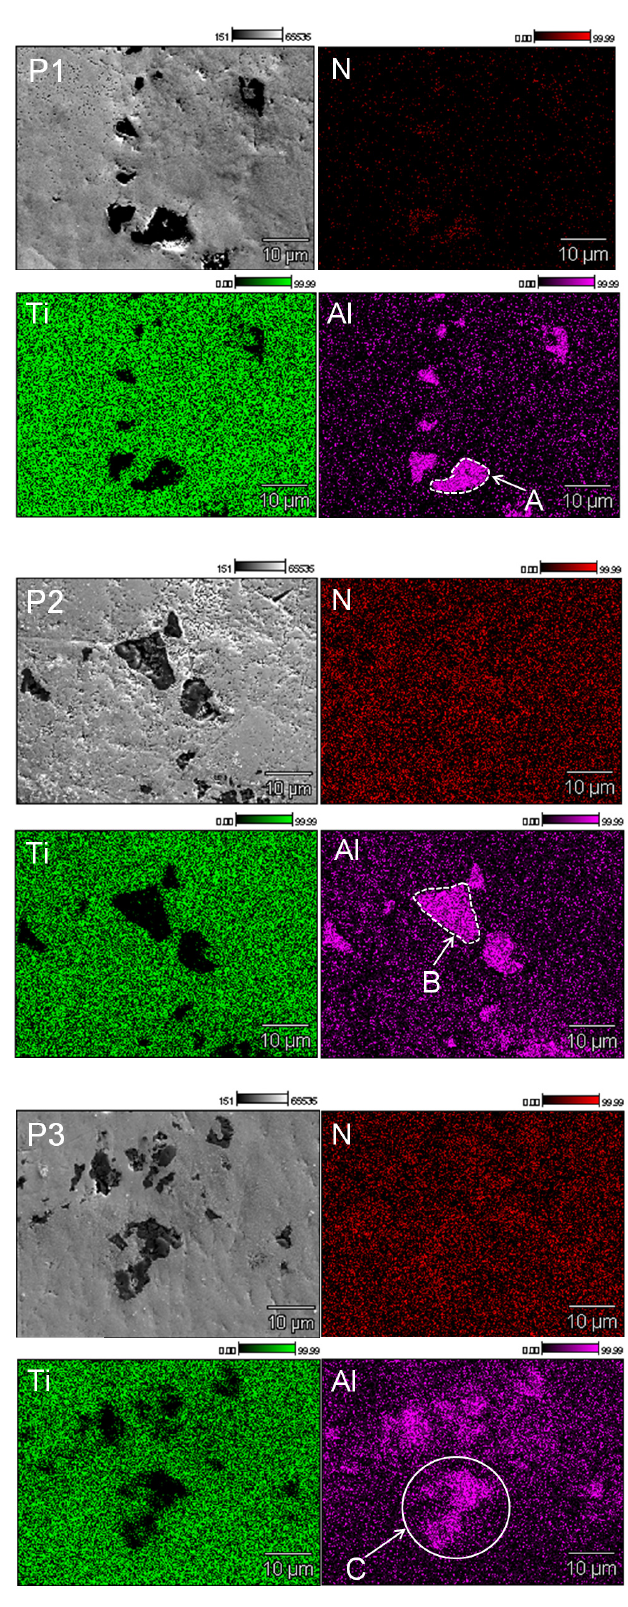
Figure 5. Distribution of elements: Al, Ti, Cr, and N on a cross-section of the samples (Energy-Dispersive Spectroscopy (EDS) mapping). ( A , B ) Clear, ( C )-fuzzy; boundary between AlN and Ti matrix.